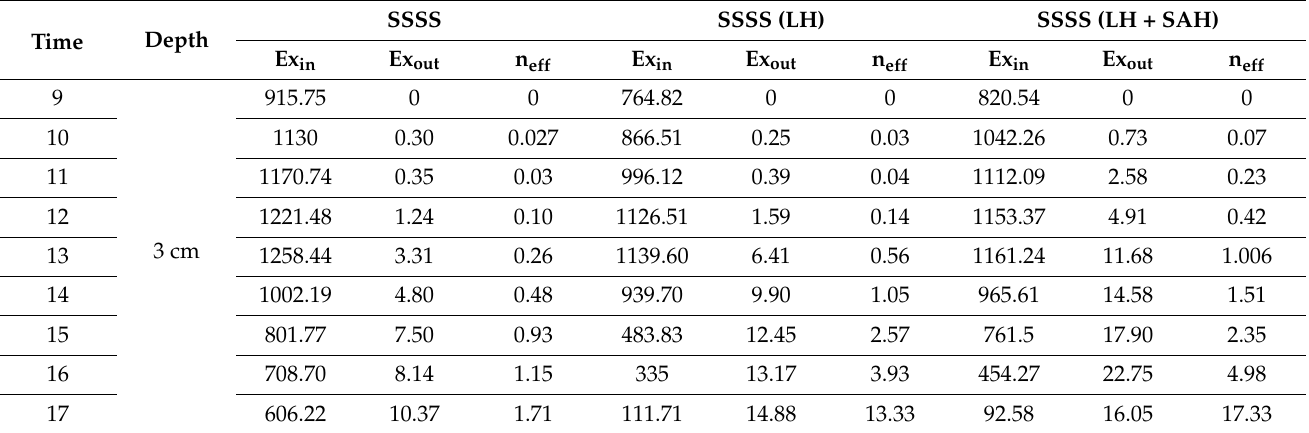
Table 3. Exergy analysis of SSSS, SSSS (LH) and SSSS (LH + SAH) at the depth of 3